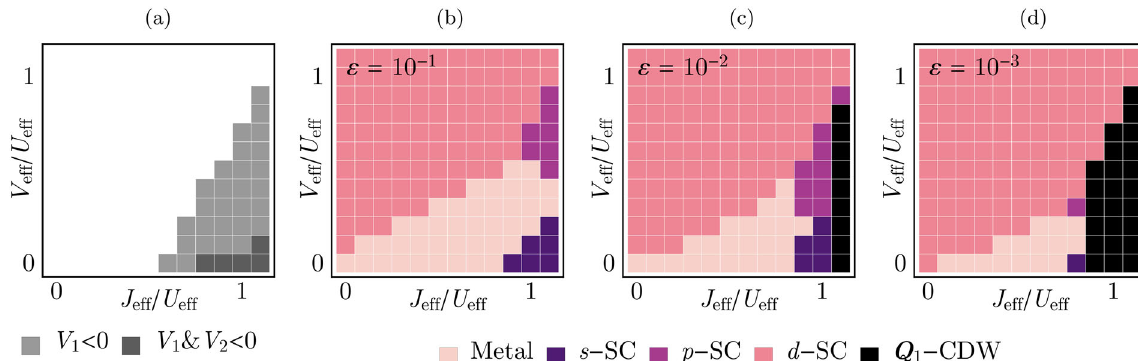
Fig. 1 Phase diagrams of our extended Hubbard model for monolayer 1T-VSe 2 . a An illustration of the mapping between the effective nearest-neighbour Coulomb repulsion V eff and the effective Heisenberg exchange interaction J eff and the coupling constants V 1 and V 2 , de fi ned in (9). b – d Calculated phase diagrams for our model of monolayer 1T-VSe 2 . The assumed degree of Fermi surface nesting increases from left to right ( ε = 10 − 1 , 10 − 2 , 10 − 3 ), and the parameter β that represents the fi nite length of the nested sections is set to 1/2. As well as the metallic phase, we fi nd regions of s-wave superconductor ( s -SC), p-wave superconductor ( p -SC), d-wave superconductor ( d -SC), and a charge density-wave with wavevector Q 1 ( Q 1